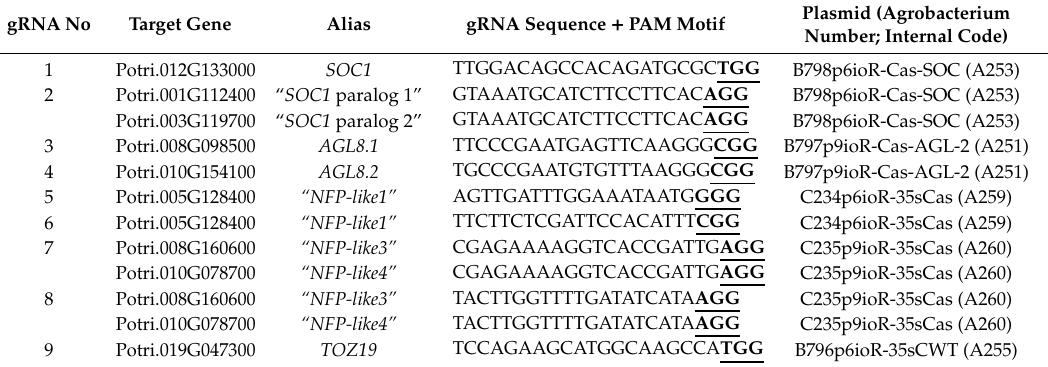
Table 7. Target genes, gRNA sequences, and transformation vectors. Regarding SOC1 paralog